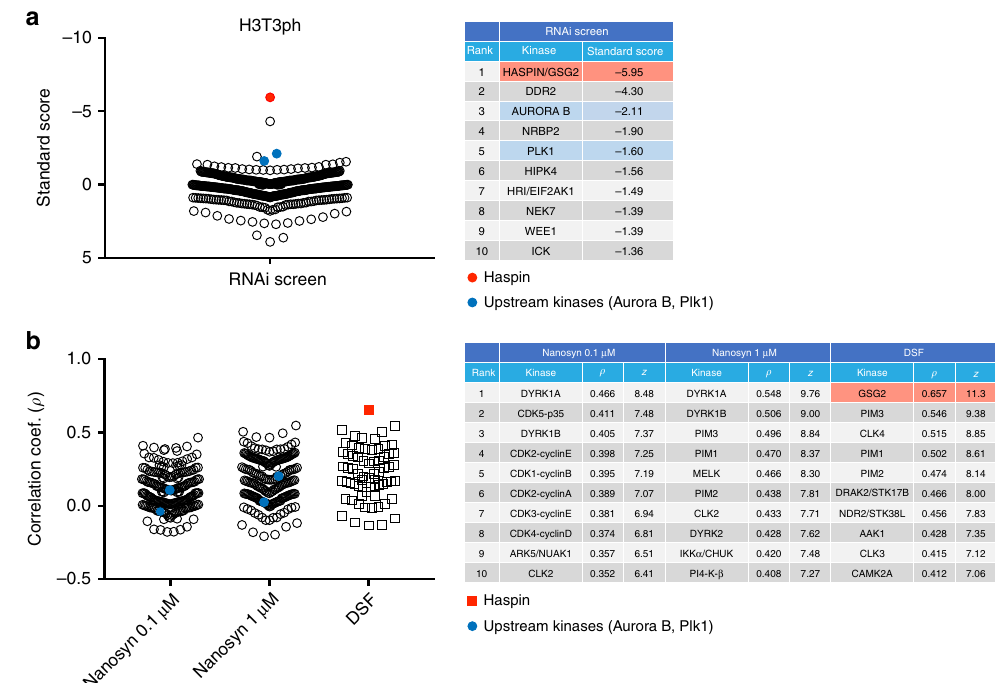
Fig. 3 Results of RNAi and KiPIK screens for H3T3ph. a A kinome-wide RNAi screen for H3T3ph in mitosis was carried out in HeLa cells using immuno fl uorescence and High Content Analysis. The stripchart on the left shows the standard score (proportional to staining intensity) for each protein kinase in the library. The table on the right shows the top 10 protein kinase hits from the screen with corresponding standard scores. b Results of a KiPIK screen using the PKIS1 inhibitor library for H3T3ph. The stripcharts on the left show the Pearson correlation coef fi cients with each kinase in the Nanosyn pro fi ling datasets at 0.1 and 1 µ M, and the DSF pro fi ling dataset. The table on the right shows the top 10 hits from each pro fi ling dataset with corresponding correlation coef fi cients and z -scores. The expected kinase (Haspin/GSG2) is shown in red, and kinases that are known to indirectly modulate H3T3ph are shown in blue. Note that Haspin/GSG2 is not present in the Nanosyn datasets. Source data are provided as a Source Data fi